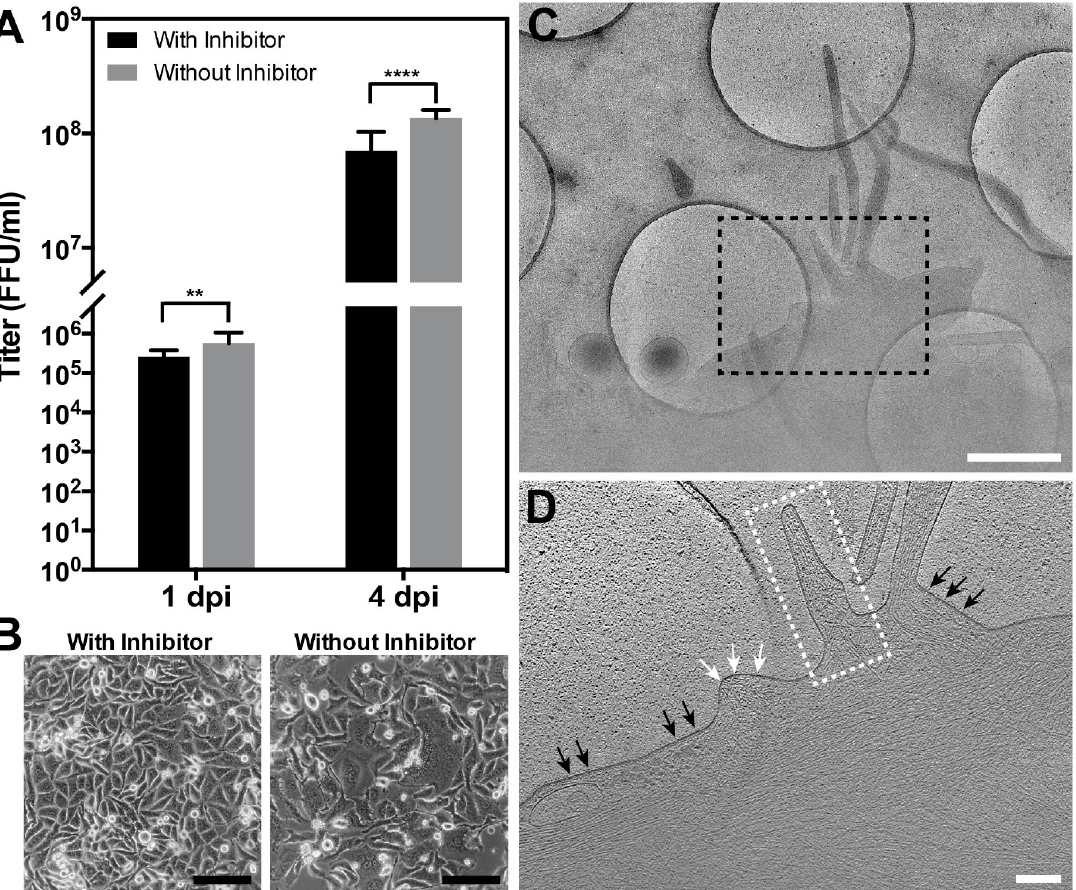
Figure 9. RSV assembly in the presence of fusion inhibitor. RSV-infected HeLa cells were infected at a M.O.I. of 10, washed twice with PBS prior to adding 600 nM RSV fusion inhibitor (BMS-433771), and incubated for the indicated length of time. ( A ) Titration results of RSV-infected cells with or without RSV fusion inhibitor at 1 and 4 d.p.i. ** indicates the student t -test p -value is below 0.01. **** indicates the student t -test p -value is below 0.0001. ( B ) Representative images showing the absence of syncytial formation with inhibitor and syncytial formation without inhibitor. ( C ) Polygon montage of an assembly site. Micrographs were acquired using cryo-EM/ET, demonstrating the assembly events at 24 h.p.i. ( D ) Tomographic slice (6.14 nm) of the assembly site collected from the region indicated by the dashed black box in ( C ). The black arrows indicate the early assembly events prior to RSV filament elongation. Note the presence of matrix layer and the glycoproteins. The white arrows indicate the plasma membrane; note the absence of the matrix layer and the glycoproteins. The dashed white box indicates an elongating RSV filament. Scale bars are 100 μ m ( B ), 1 μ m ( C ), and 200 nm ( D ).